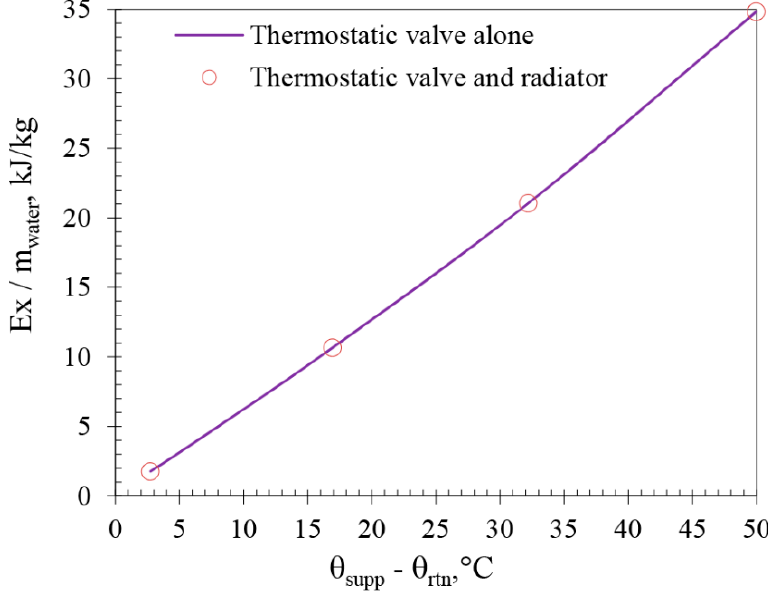
Figure 8. The variation of exergy use per unit mass of water at different temperature drops across a conventional radiator. The calculations are based on a K v -value of 0.45.